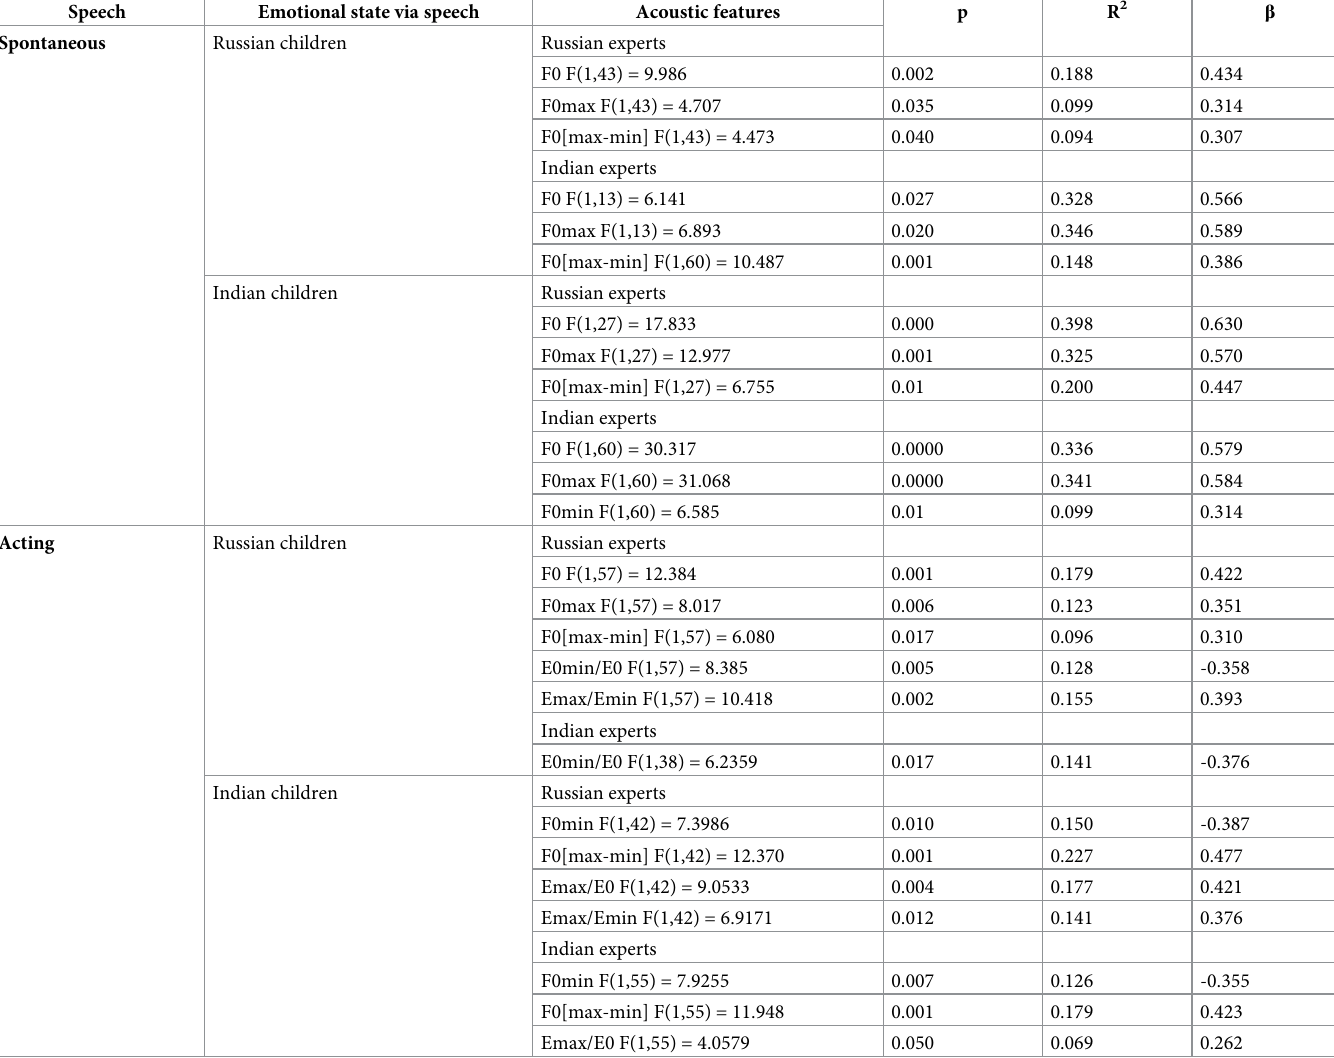
Table 13. Acoustic features of child speech predictors for the recognition of the emotional states (Regression analysis).